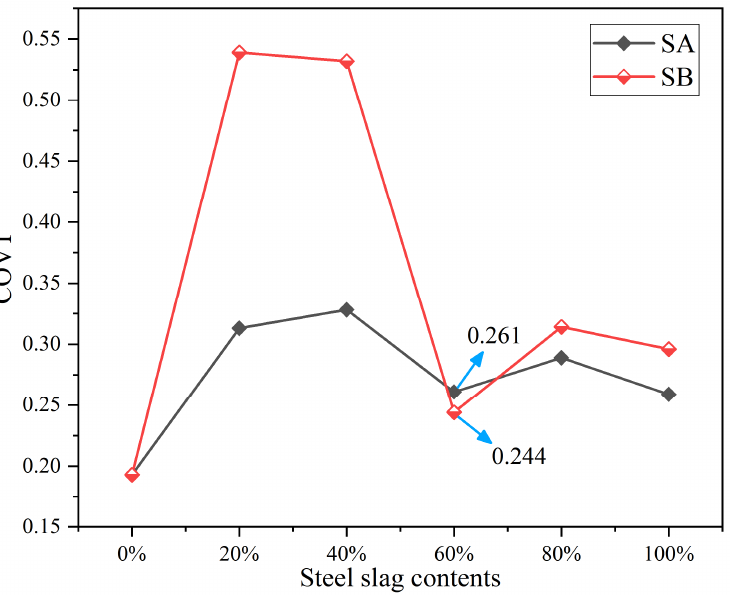
Figure 13. The effect of steel slag contents on the uniformity of temperature distribution at 40 s.